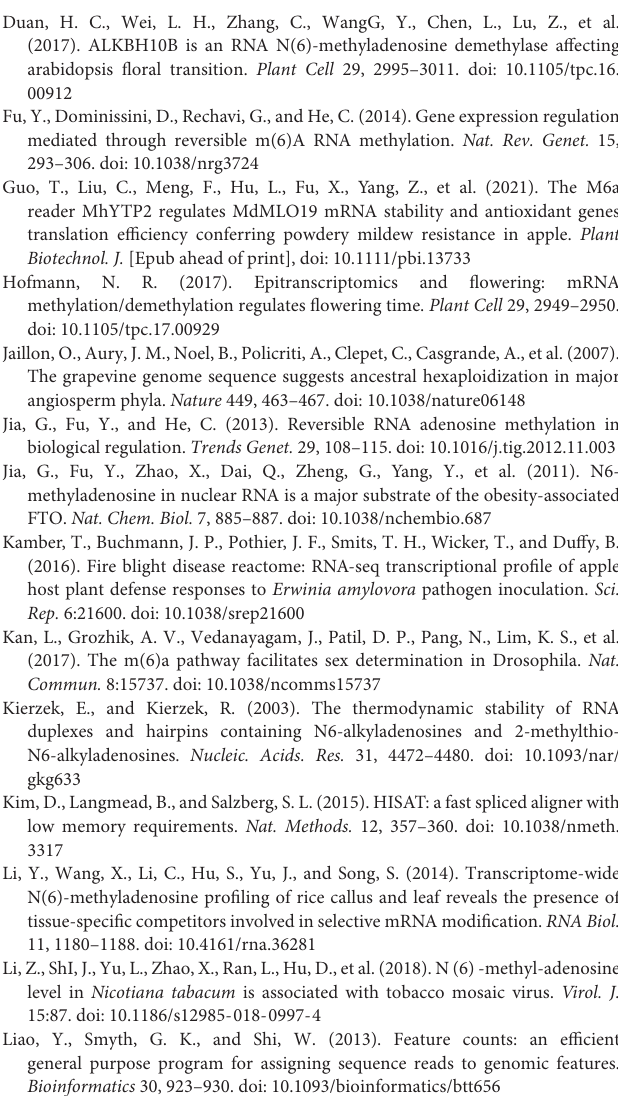
K a /K s > 1 in TRD and DSD. (H–K) Expression divergence among duplicate genes derived from non-m 6 A, single-m 6 A, and both-m 6 A in PD, TRD, DSD, and TD. Supplementary Figure 5 | LC-MS/MS quantification of RNA modification in mock and 12 HPI plants. Supplementary Figure 6 | qRT-PCR and m 6 A-IP-qPCR assay of m 6 A-modified genes. (A) m 6 A-IP-qPCR validation of m 6 A methylation level of 10 randomly selected genes from Supplementary Table 6 . (B) Relative mRNA levels. ∗ p < 0.05; ∗∗ p <